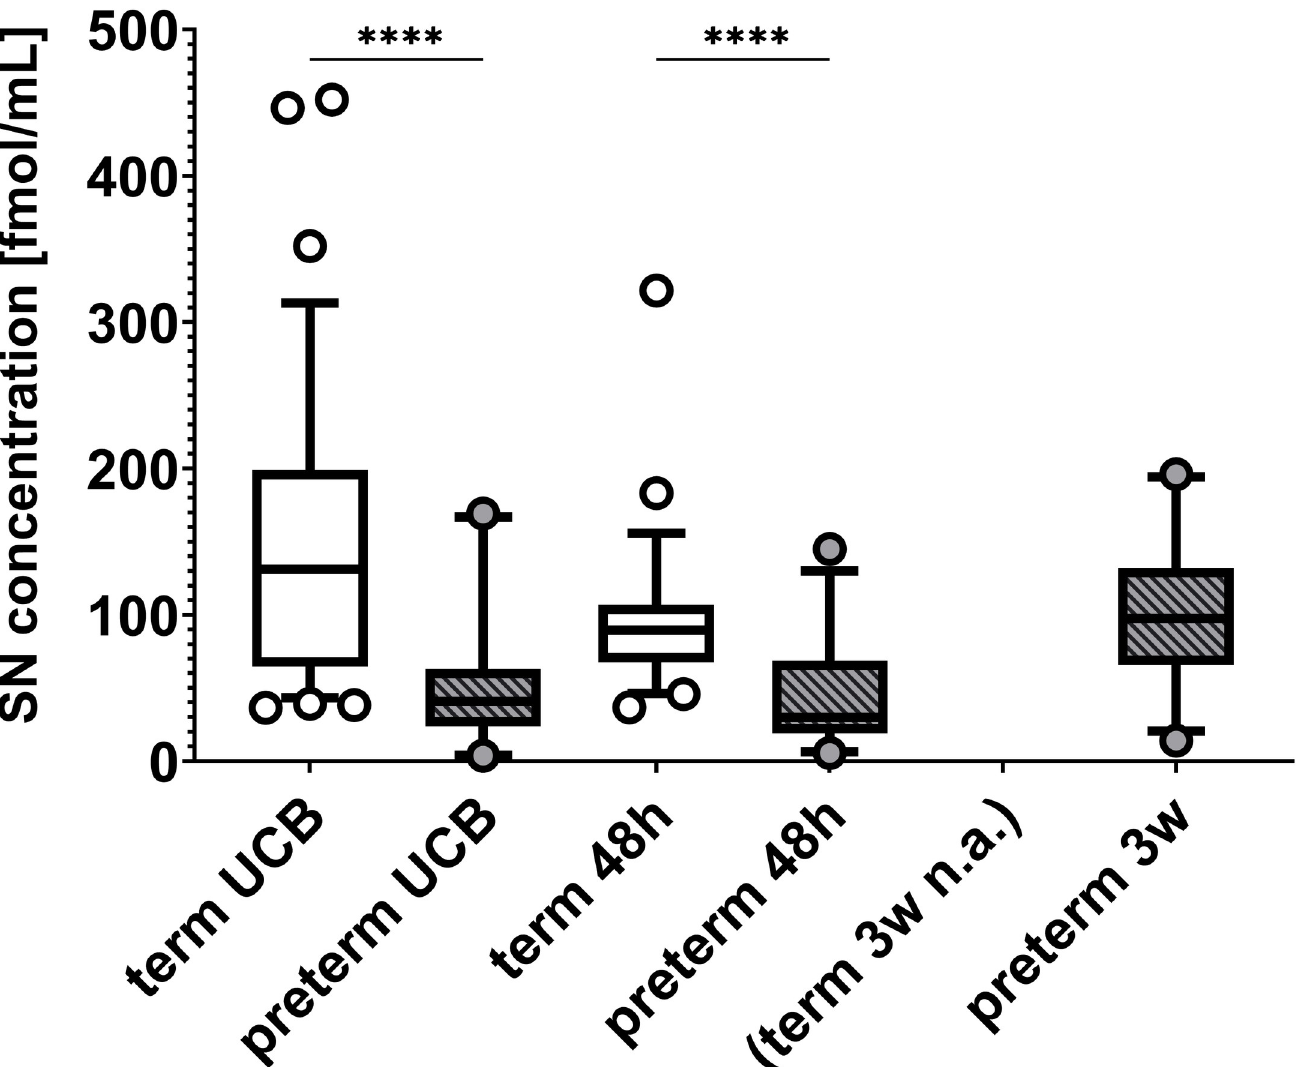
Fig 2. Secretoneurin (SN) levels in healthy term- and preterm-born infants at different time points. SN serum concentrations were determined in umbilical cord blood (UCB), and in patient blood samples obtained at 48 hours (48h) and three weeks (3w) of life. Comparisons were made using 2:1 propensity score matching based on sex and birth weight standard deviation scores (calculated with Fenton 2013 percentiles). Reference values for 3 weeks of life were not available (n.a.). In comparison to term neonates, preterm-born infants had significantly lower SN concentrations in UCB and in blood samples obtained at 48 hours of life. SN concentrations are depicted in fmol/mL. Centre lines in boxes represent medians, box edges mark 1st and 3rd quartiles, and whiskers indicate 5th and 95th percentiles. **** p <